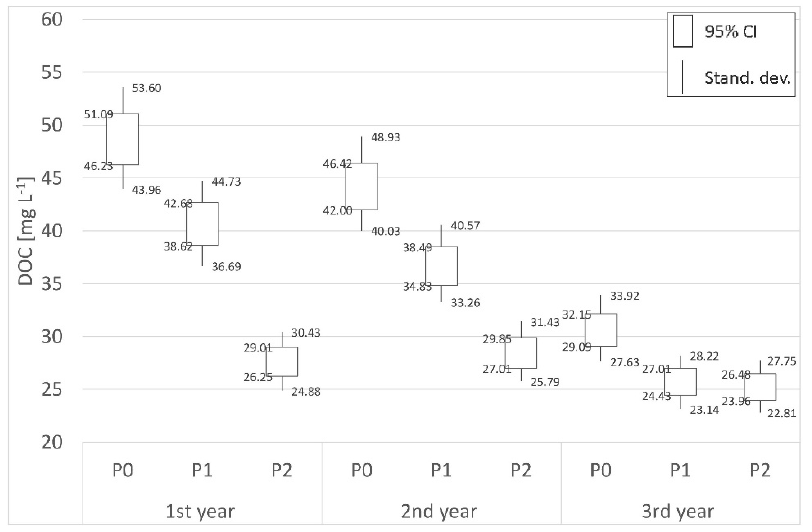
Figure 4. The concentrations of DOC in groundwater under peatland soils.